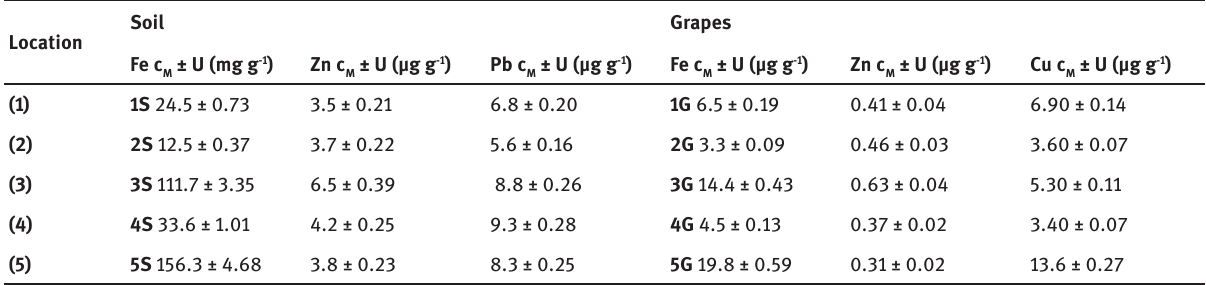
) in the soil and grapes. Table 4: The concentrations of metals ( c M Soil Grapes Location